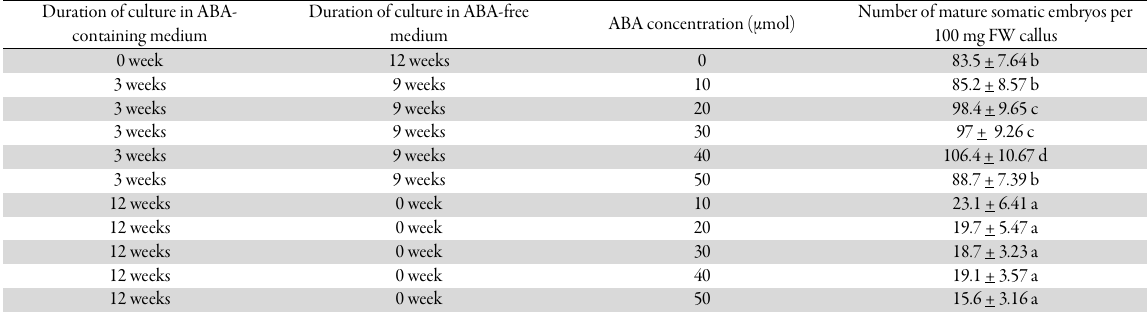
Table 3. Effects of ABA concentration and the duration of culture in ABA-containing medium on somatic embryo maturation after 12 weeks of culture Duration of culture in ABA- containing medium